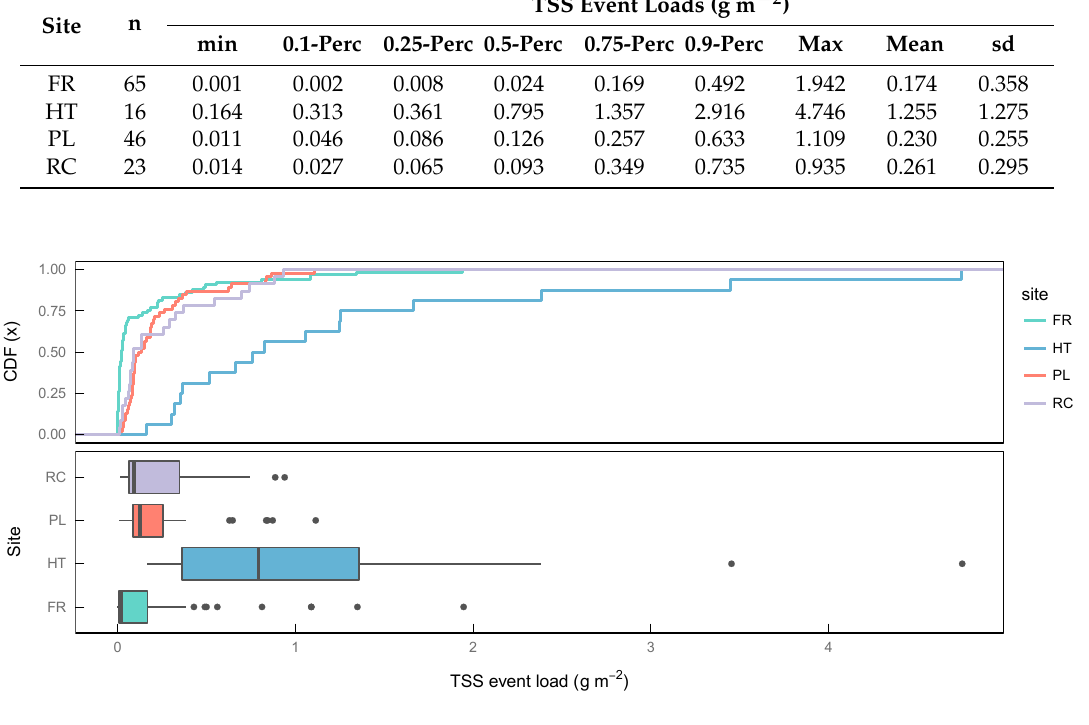
Figure 1. Empirical cumulative distribution functions and boxplots of site-specific monitored Total Suspended Solids (TSS) event loads (FR: Flat Roof, HT: High Traffic Street, PL: Parking Lot, RC: Residential Catchment).